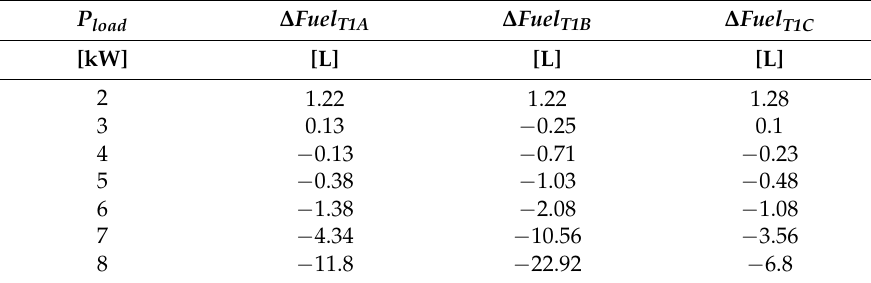
Table 5. Fuel economy for the RTO1 strategy using different k fuel .